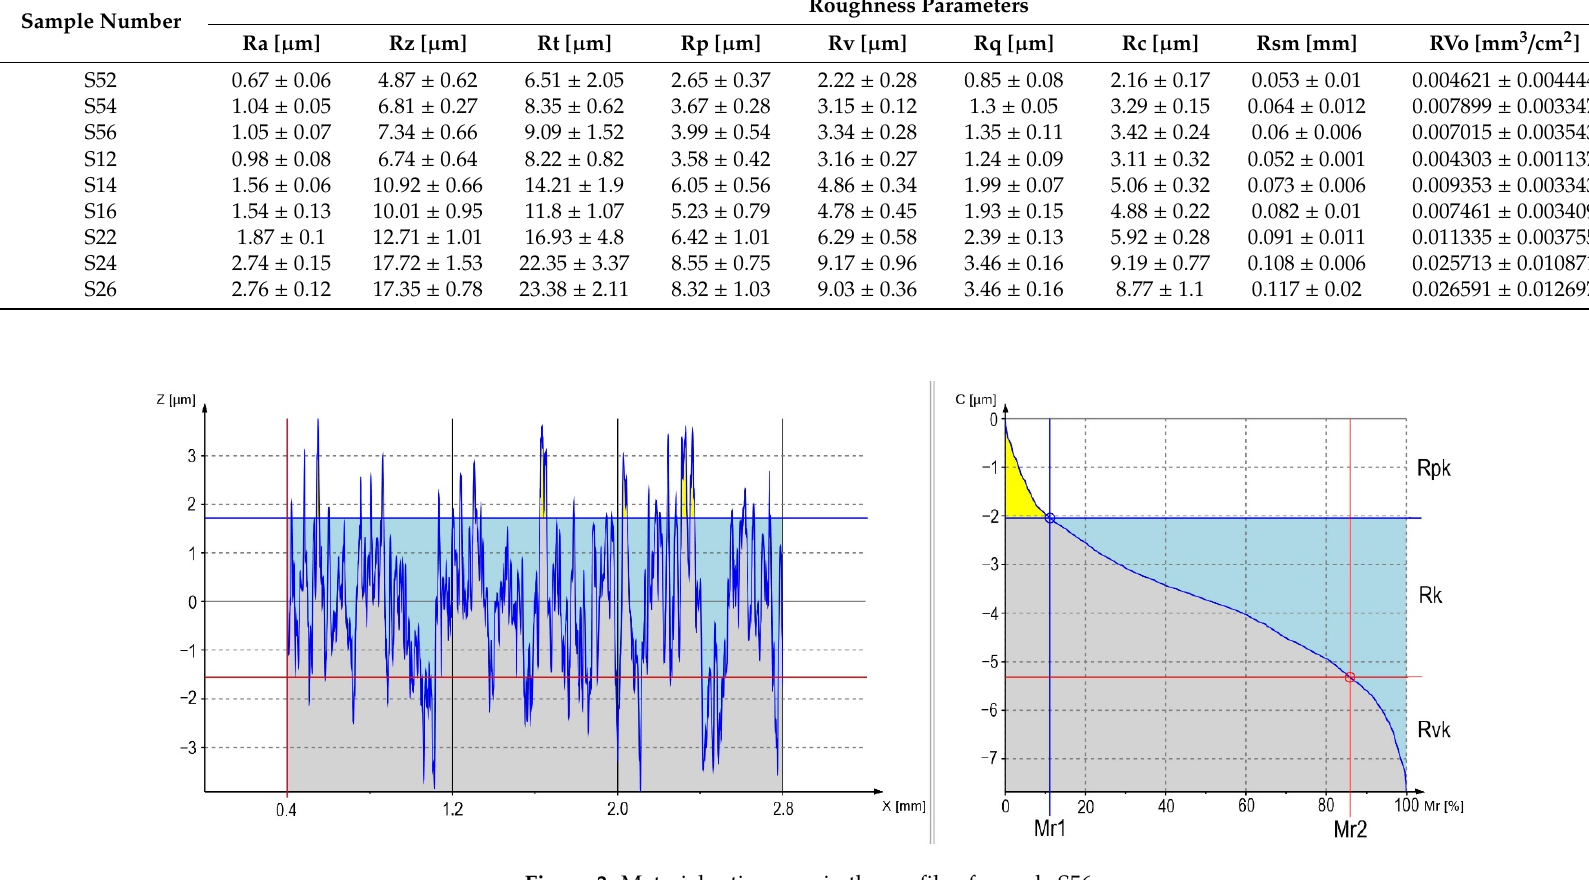
Figure 3. Material ratio curve in the profile of sample S56.